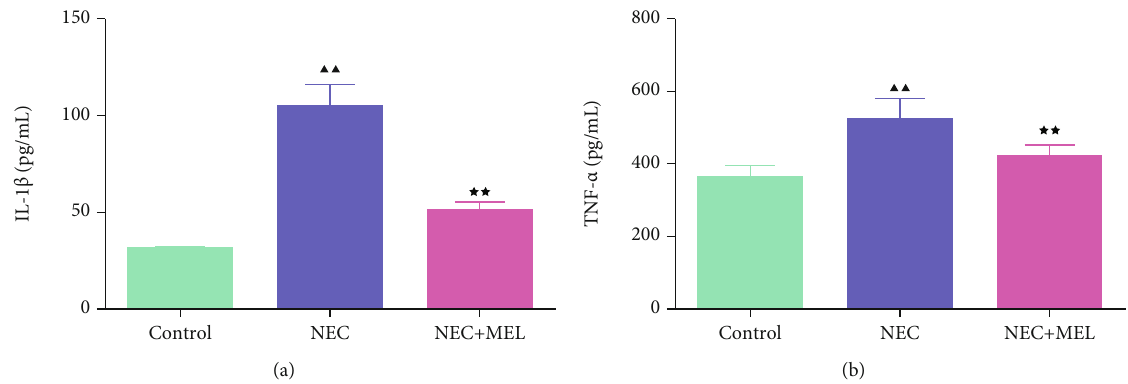
Figure 3: MEL weakened in fl ammation of serum in NEC mice. (a, b) The e ff ect of MEL on in fl ammation in NEC mice was assessed by ELISA detecting the serum interleukin 1 β (IL-1 β ) and tumor necrosis factor-alpha (TNF- α ). ▲▲ P < 0 : 01 vs. control; ★★ P < 0 : 01 vs.